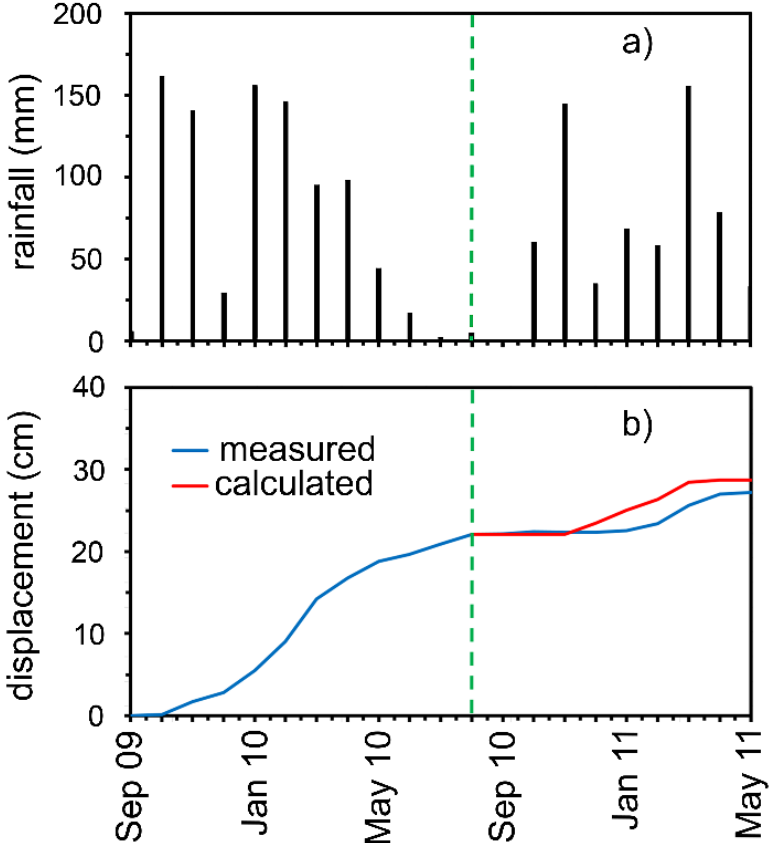
Figure 9. Prediction of soil displacement carried out by means of the proposed approach, referring to the time period from August 2010 to May 2011: ( a ) rain recordings, ( b ) horizontal displacement. The dotted line indicates the beginning of prediction.